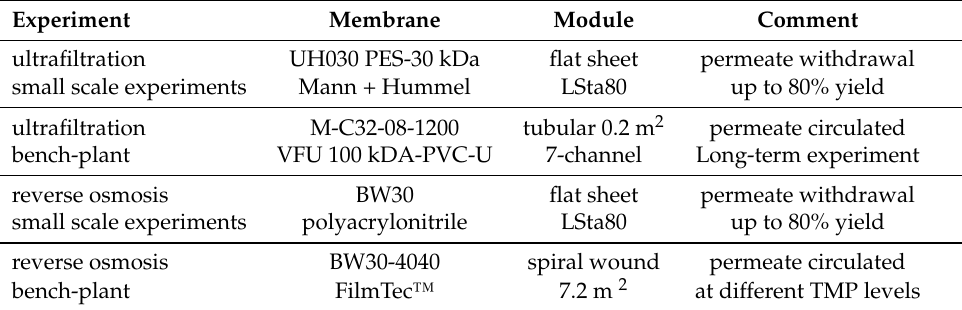
Table 4. Overview of the performed